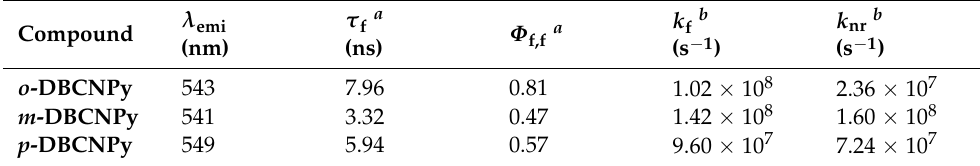
Figure 3. Fluorescence lifetimes of o -DBCNPy ( a ), m -DBCNPy ( b ), and p -DBCNPy ( c ) in THF and as neat film. Table 2. Fluorescence properties of the neat fi lms of the molecules.